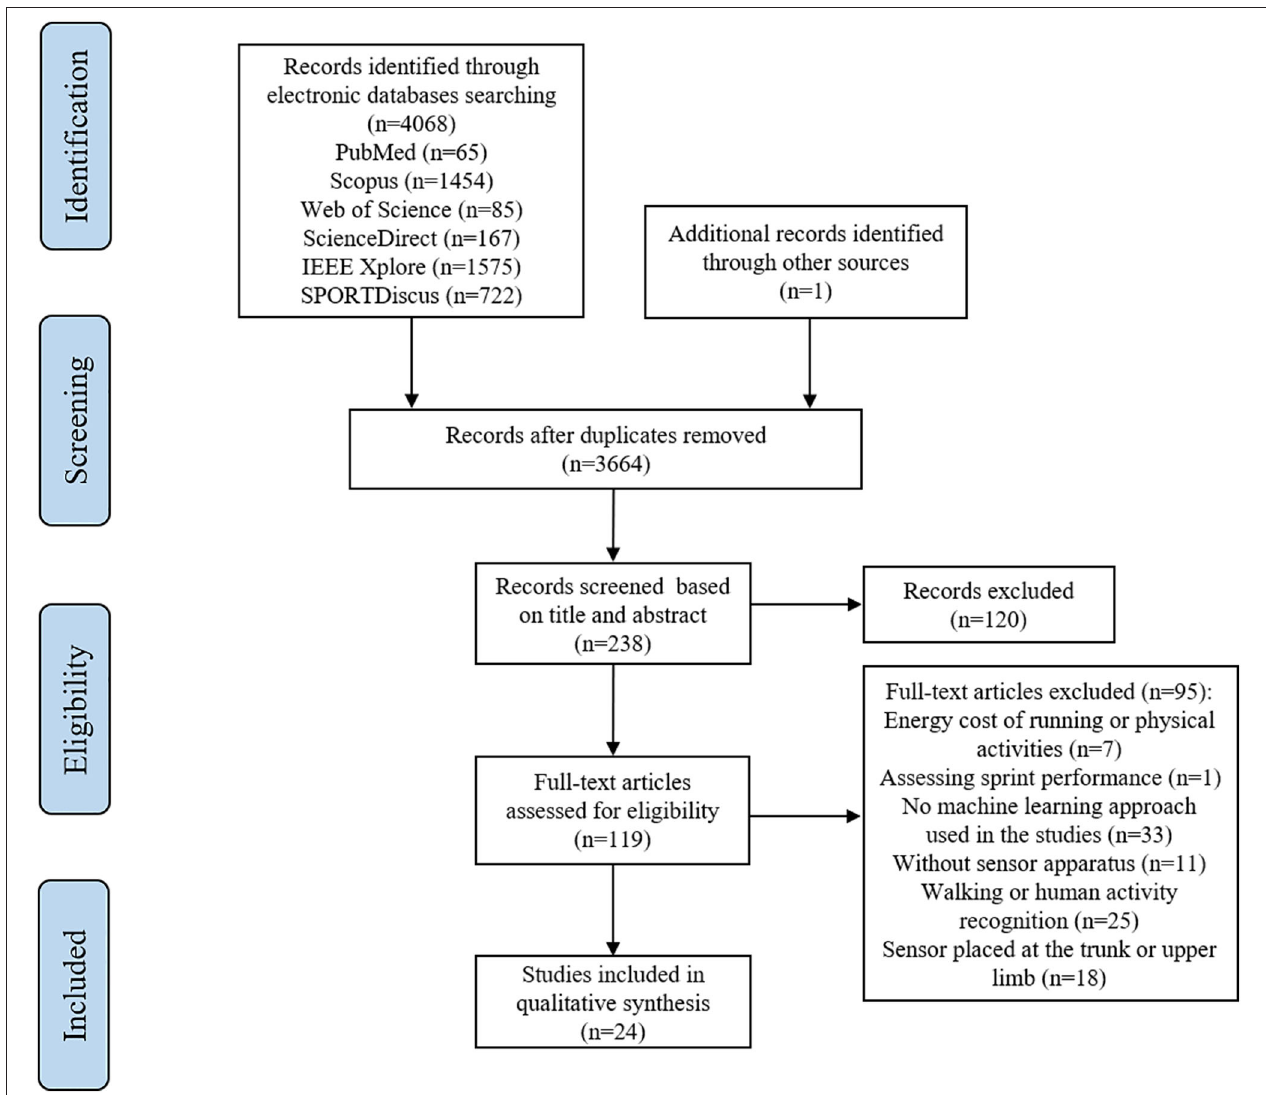
FIGURE 1 | PRISMA flow diagram for original research articles’ searching and screening